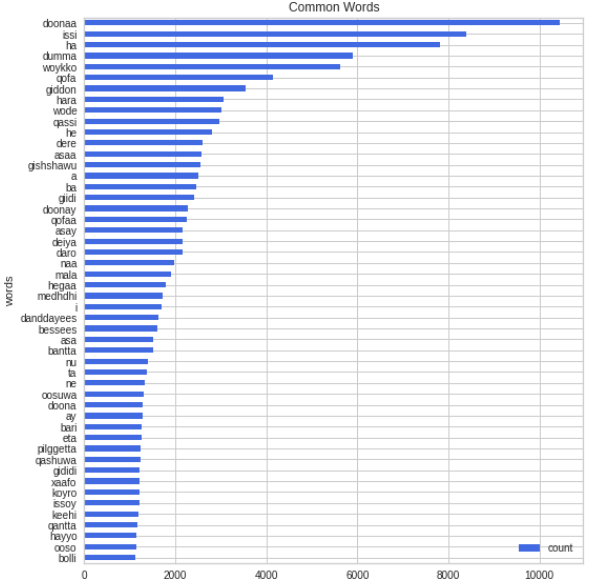
Figure 2. Fifty most common words in Wolaytta monolingual data.